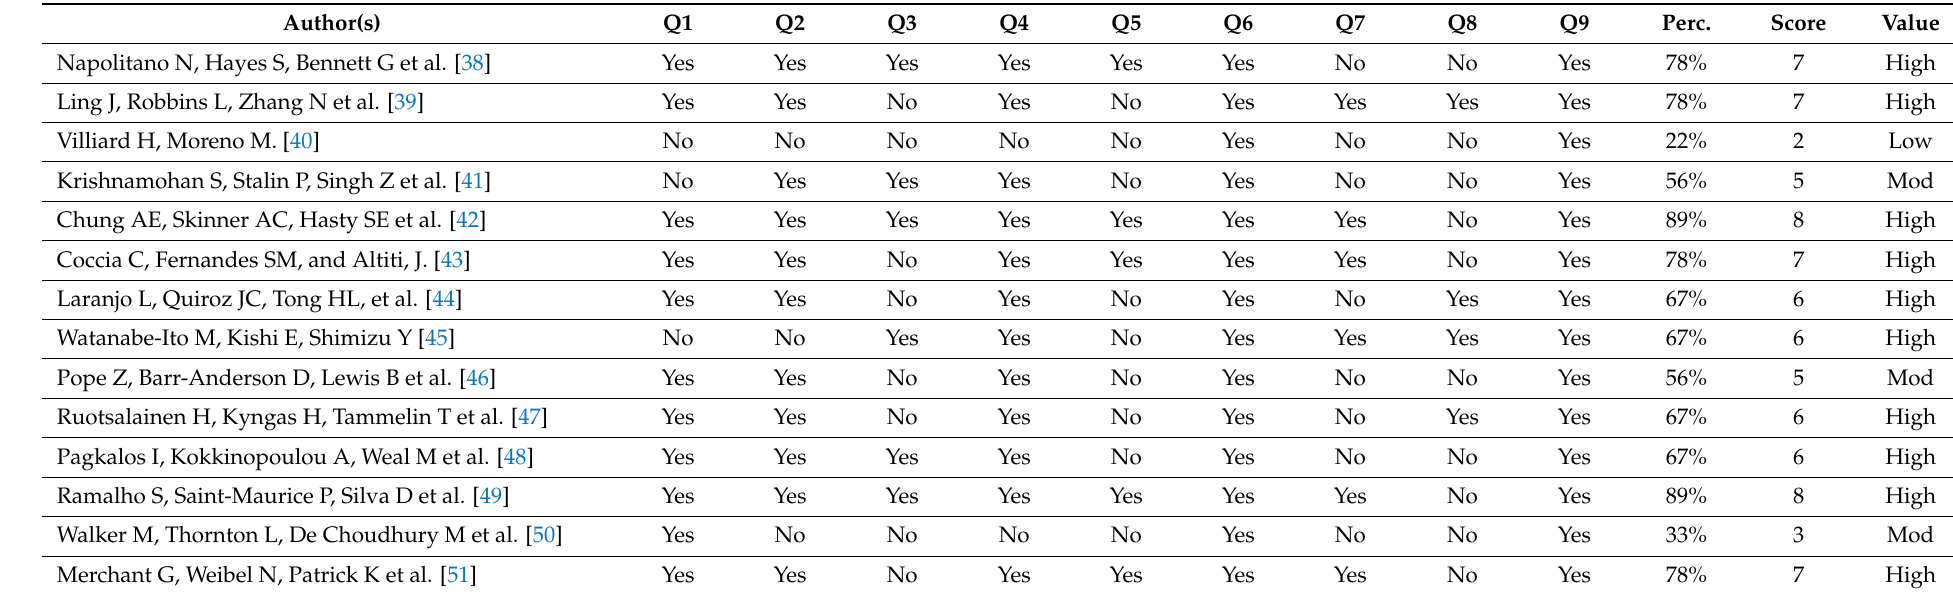
Table A2. Scoring system in Norman et